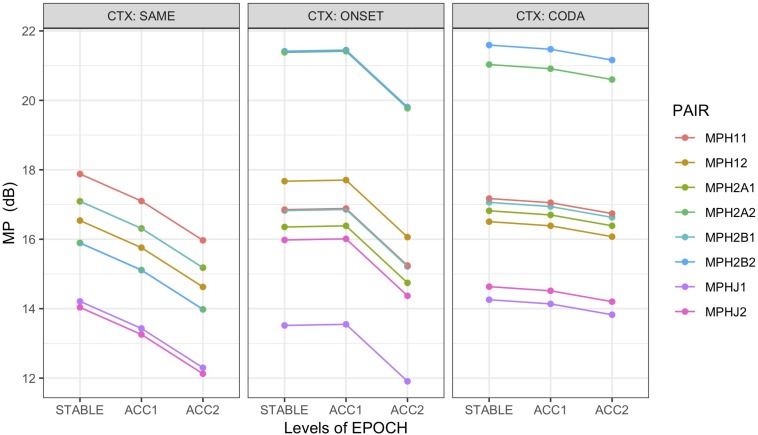
Marginal means by condition for mutual power (MP) between PC1 of HEAD with non-alternating articulator (MIH1x), first (MIH2Ax) and second (MIH2Bx) alternating articulators, and JAW (MIHJx), grouped over speakers. MP assessed at syllable rate (x = 1) and alternating rate (x = 2). Trials with errors excluded from analysis. For non-alternating control pairs (CTX:SAME), ART1 was the coda trajectory, and both ART2A and ART2B were mapped to the onset trajectory. Error bars suppressed for legibility.